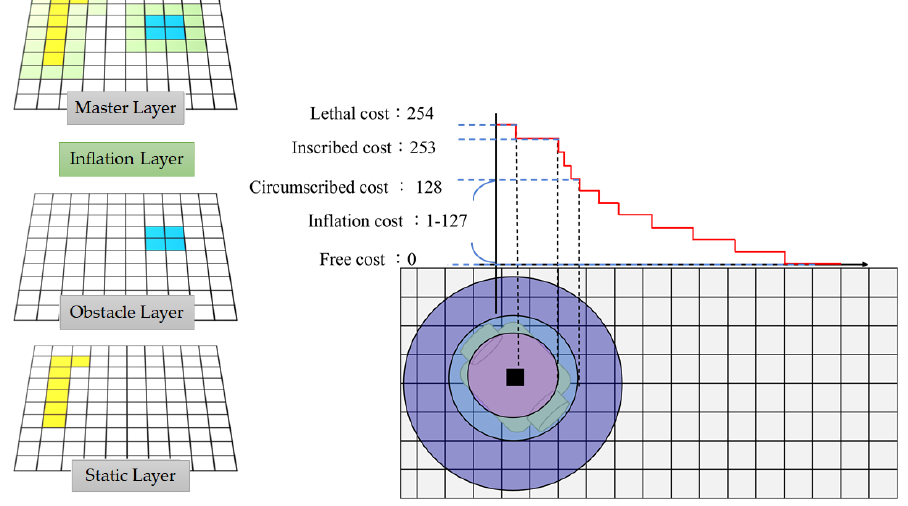
Figure 2. ROS cost map with multiple layers.